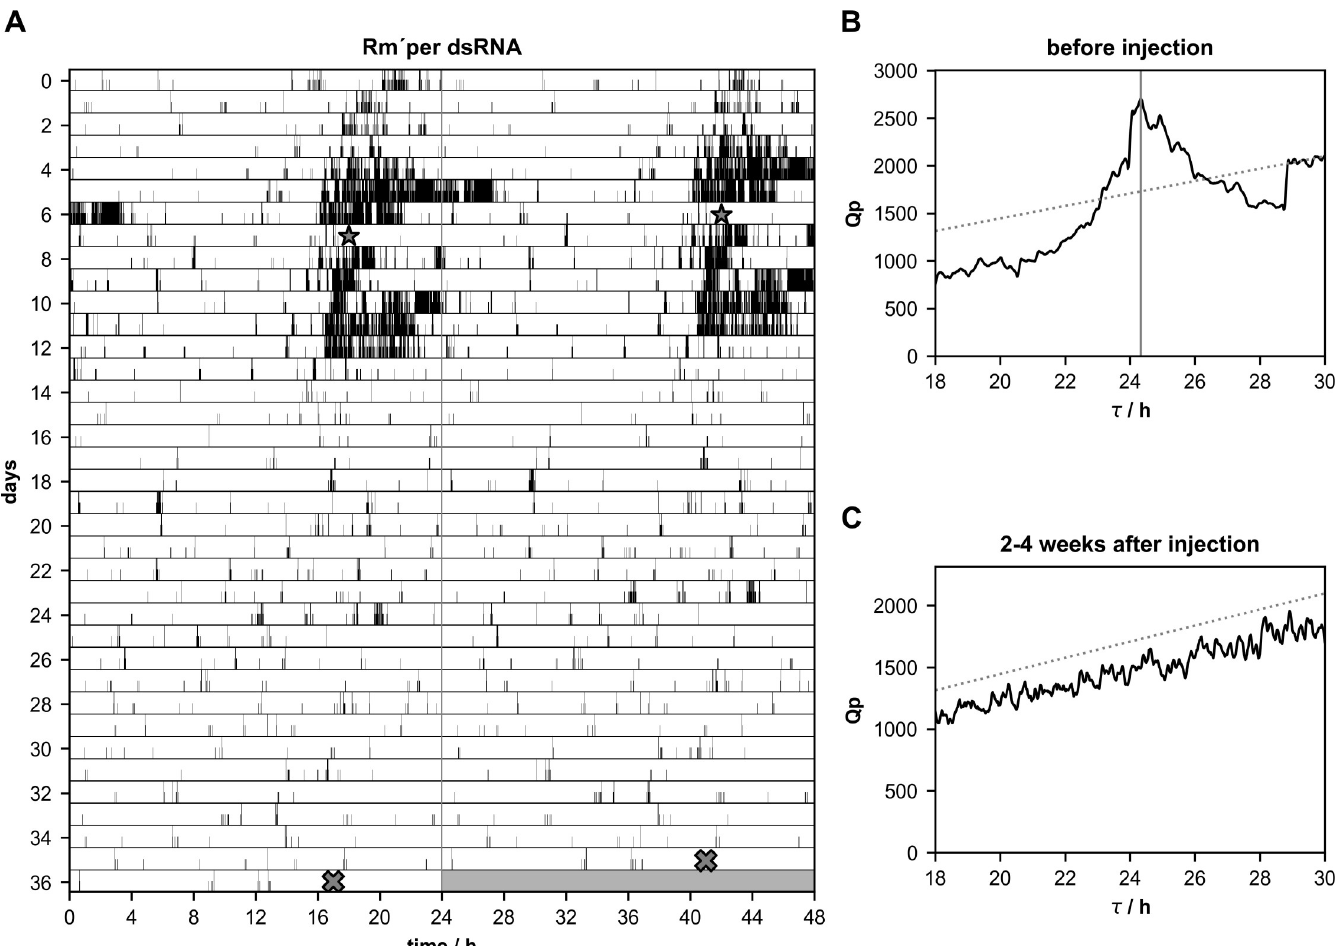
Fig 2. A-C. Injections of Rm´per dsRNA abolished circadian rhythmicity of running wheel locomotor activity in some Madeira cockroaches (n = 4 of 12). (A) Double- plotted running wheel activity of a Madeira cockroach in constant darkness 7 days before, and 29 days after the injection of Rm´per dsRNA (star). At day 36 of the locomotor activity recording the cockroach was sacrificed (cross) and qPCR was used to confirm the knockdown. Chi-square periodogram analysis of the number of running wheel turns indicated significant rhythmicity with a period( τ )of 24.33 h 1–7 days before Rm´per dsRNA injection (B) and loss of rhythmicity 2–4 weeks after the injection (C)